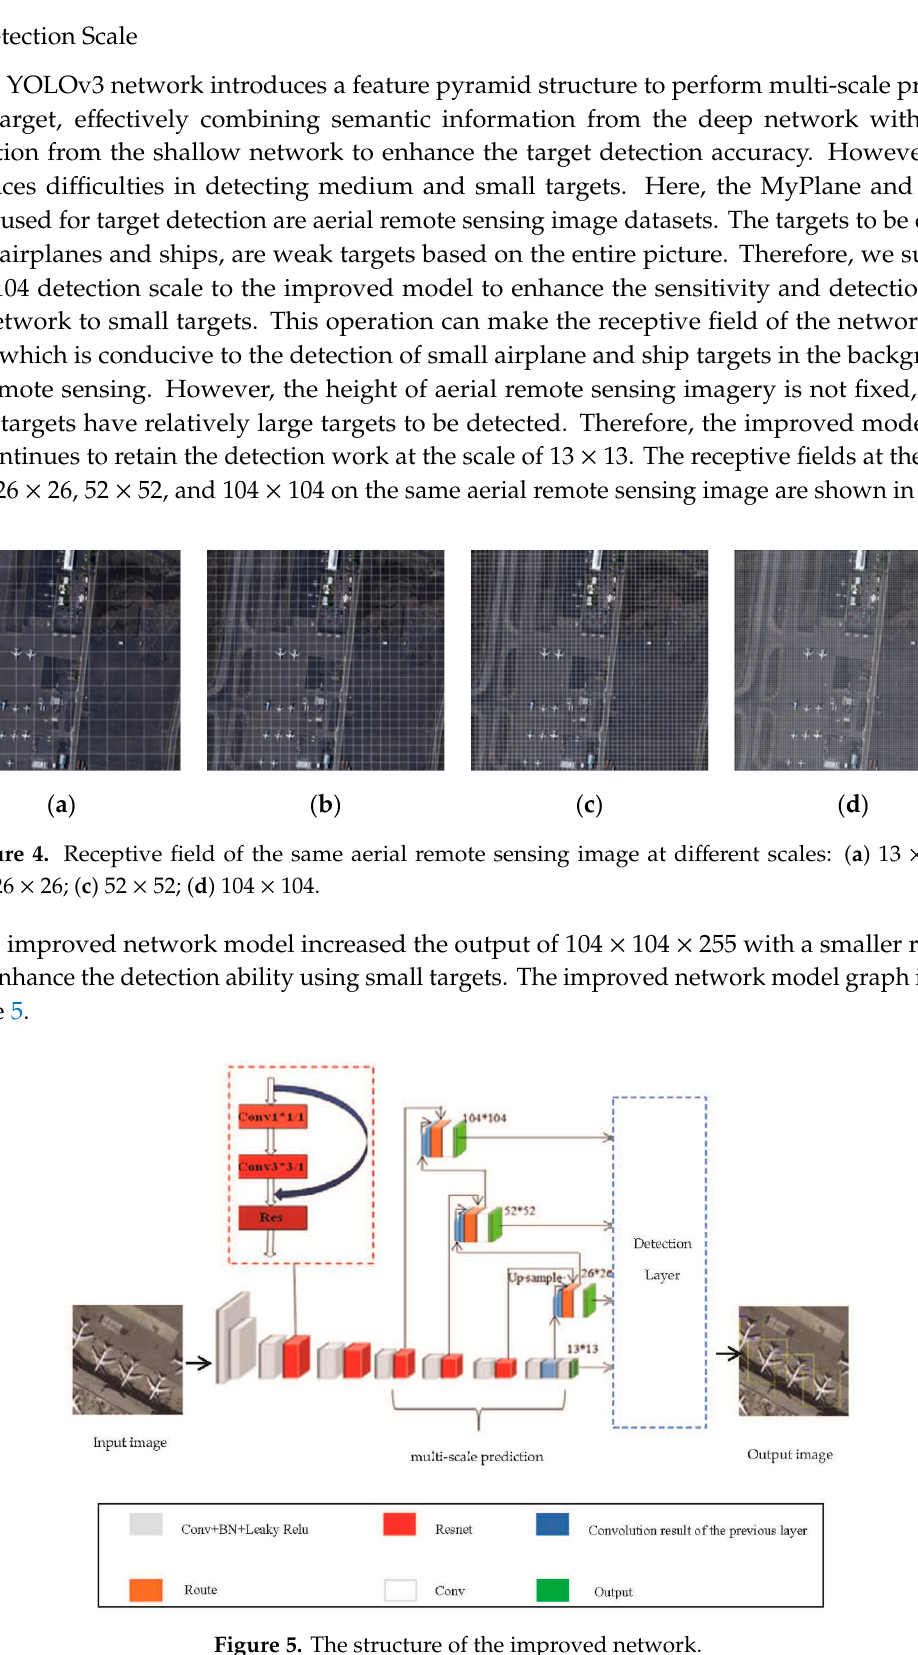
Figure 5. The structure of the improved network.